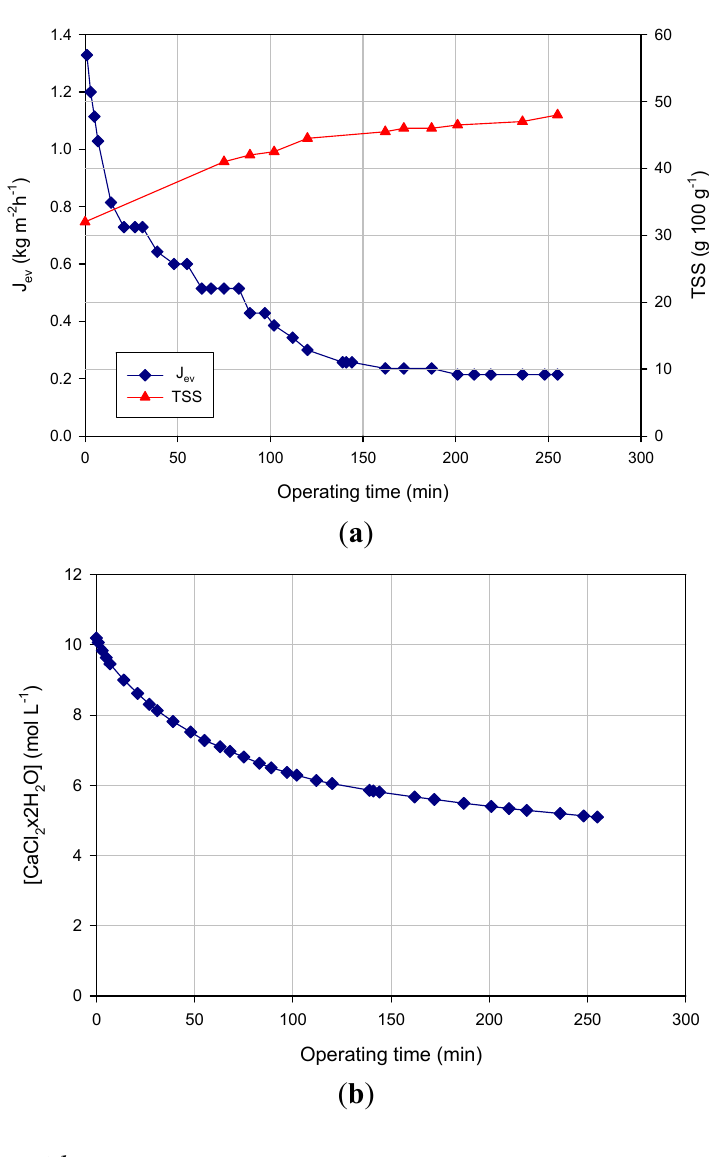
Figure 3. Concentration of NF retentate by OD. Time course of ( a ) evaporation flux and TSS; ( b ) stripping solution concentration (operating conditions: TMP, 0.28